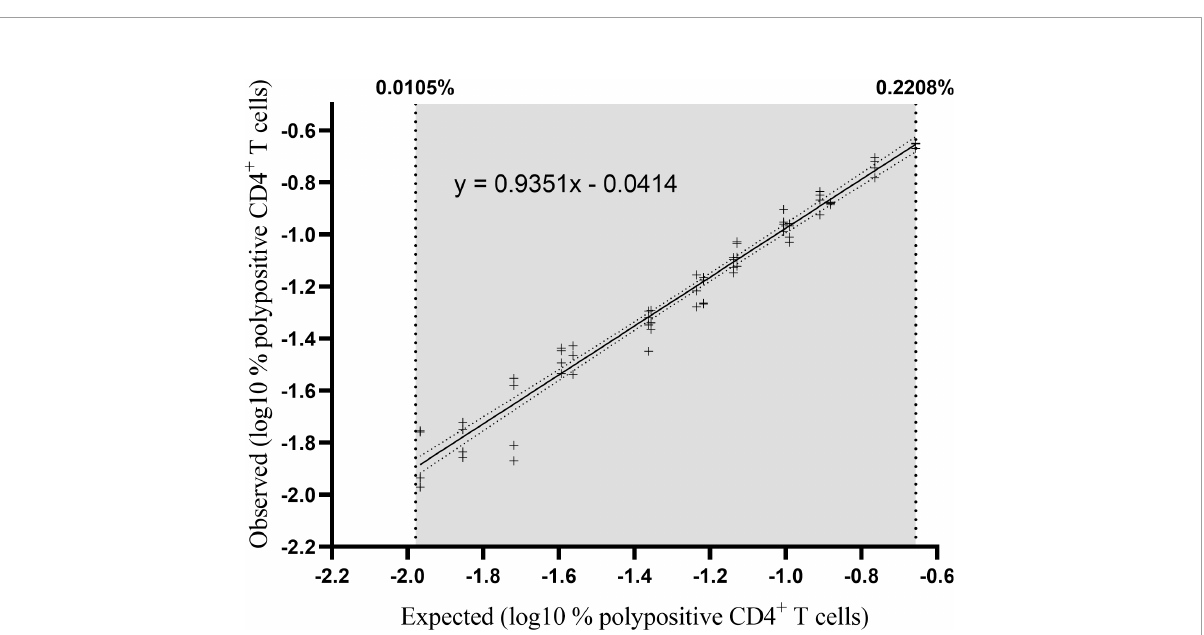
FIGURE 6 Percentage of observed versus expected corrected A/California/07/2009-speci fi c polypositive CD4 + T cells. Individual datapoints represent pairs of background-corrected observed versus expected results of 68 individual results (3 samples [high, medium and low responders], 4 replicates, 5-6 independent dilutions). The results were log 10 transformed and linearity was assessed by regressing the observed corrected against the expected corrected mean. The lower and upper limits of linearity are indicated with vertical dotted lines. The solid line represents the regression line and the dotted line represents the 95% con fi dence